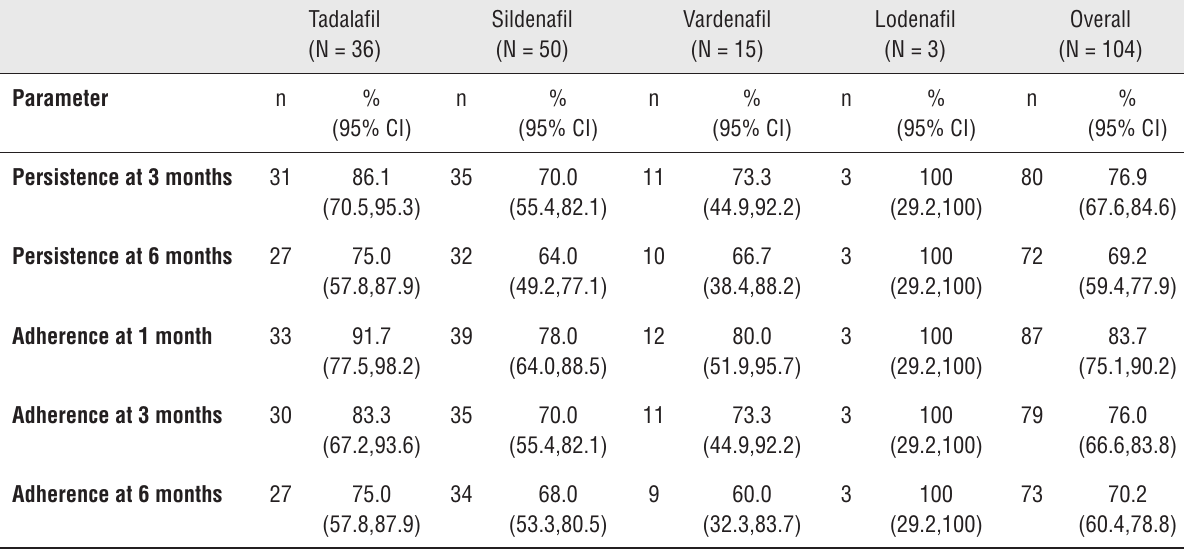
Table 2 - Treatment Persistence and Adherence.